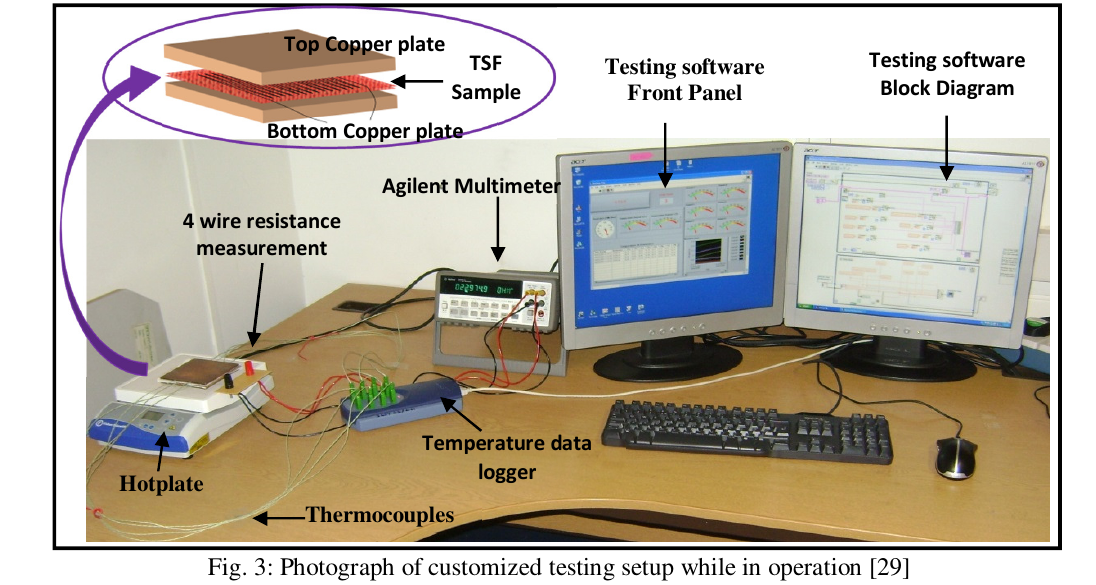
Fig. 3: Photograph of customized testing setup while in operation [29]